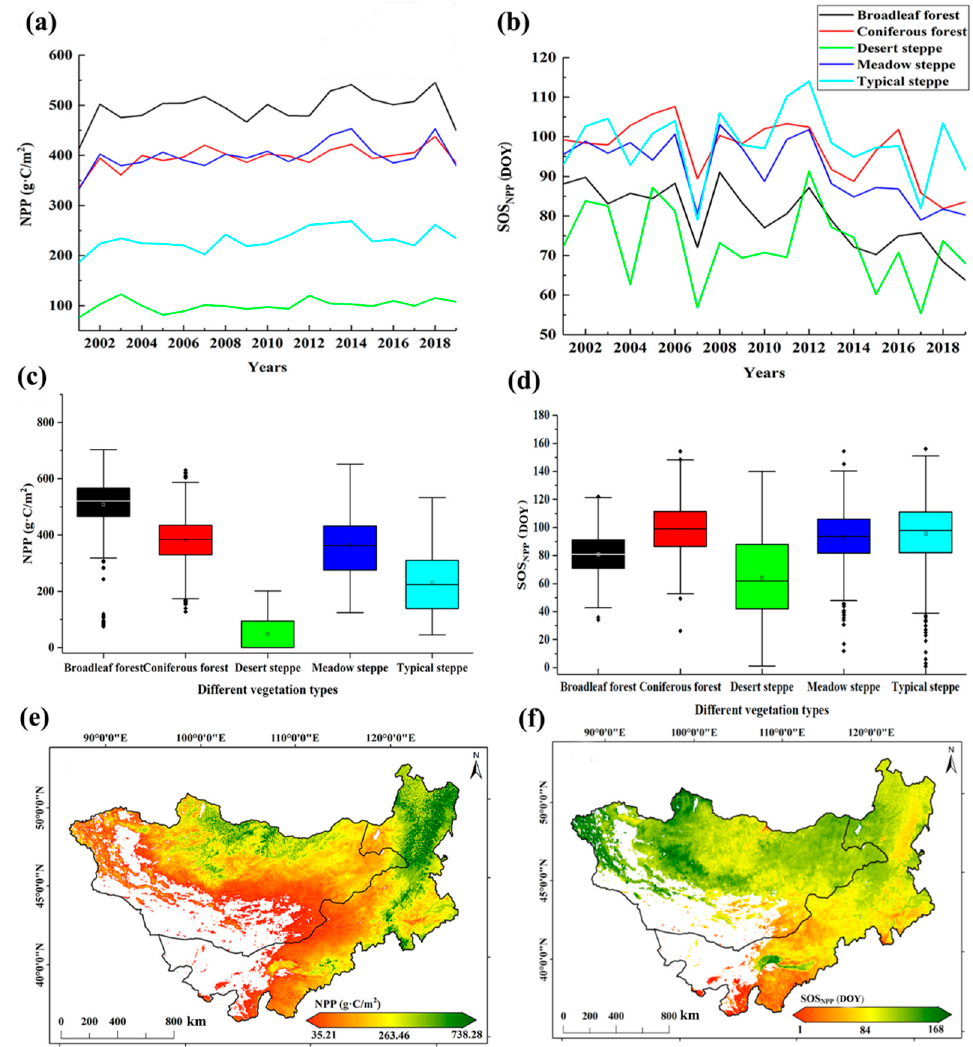
Figure 3. Different vegetation types of 2001–2019 NPP and SOS NPP over the Mongolia Plateau: ( a ) NPP change trend; ( b ) SOS NPP change trend; ( c ) NPP spatial statistics box plot; ( d ) SOS NPP spatial statistics box plot; ( e ) spatial map of average NPP distribution; ( f ) spatial map of average SOS NPP distribution.